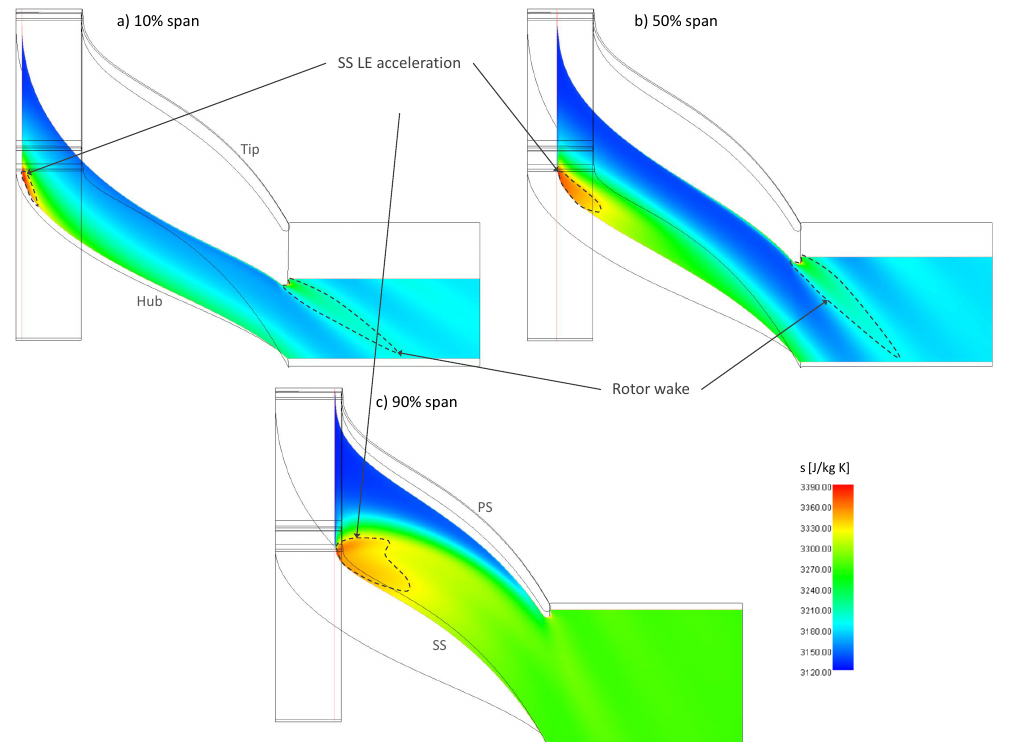
Figure 7. Entropy contours at three spanwise rotor passage locations: ( a ) 10% span, ( b ) 50% span, ( c ) 90% span.